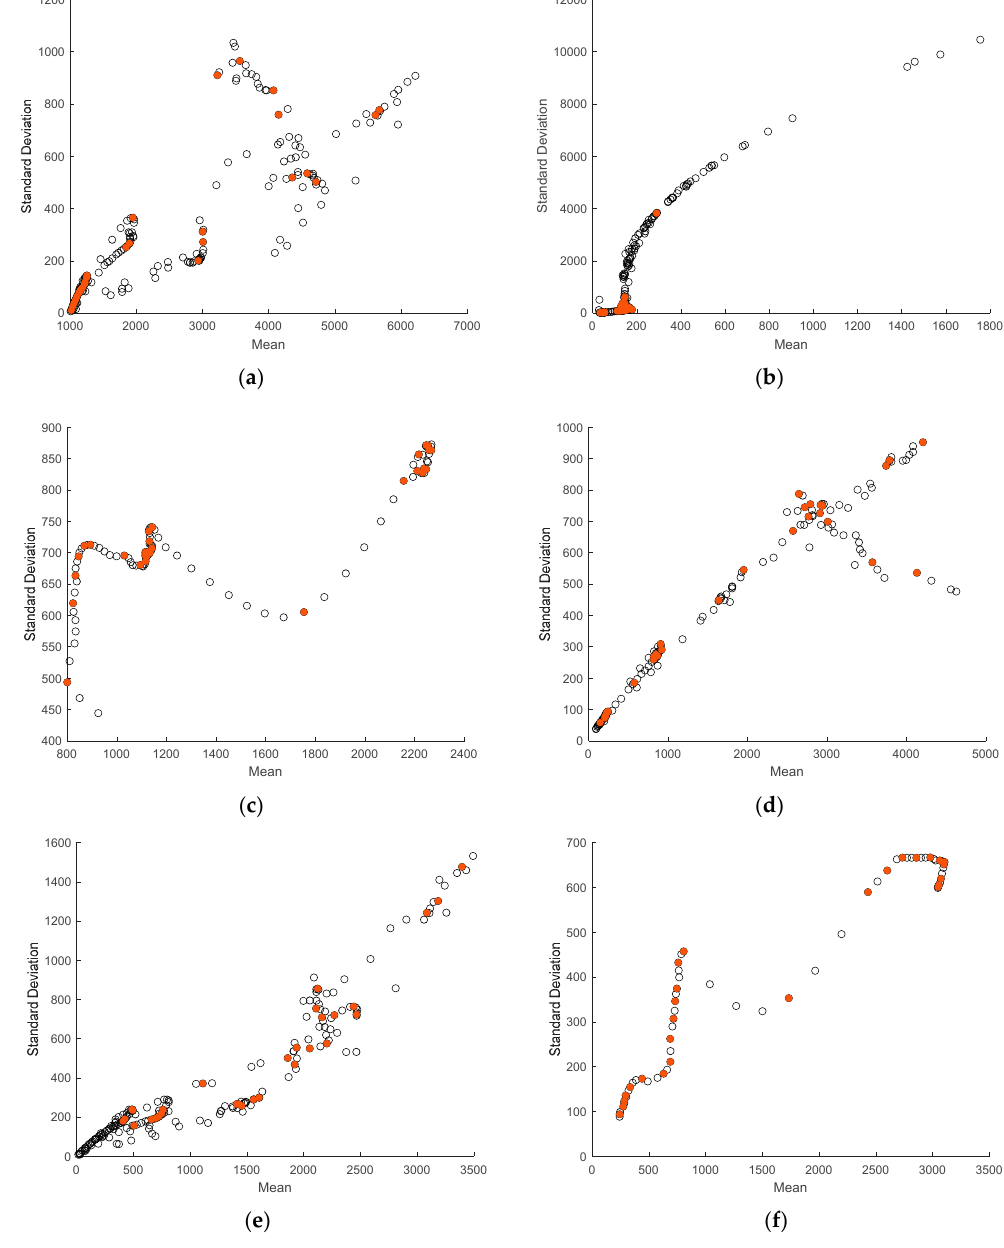
Figure 8. Scatter plot of means and standard deviations for each data set. Every circle in each figure indicates a band and the red circles represent the selected bands by the BRECVD method. ( a ) Indian Pines. ( b ) KSC. ( c ) Pavia University. ( d ) Botswana. ( e ) Salinas. ( f ) Taita Hills.